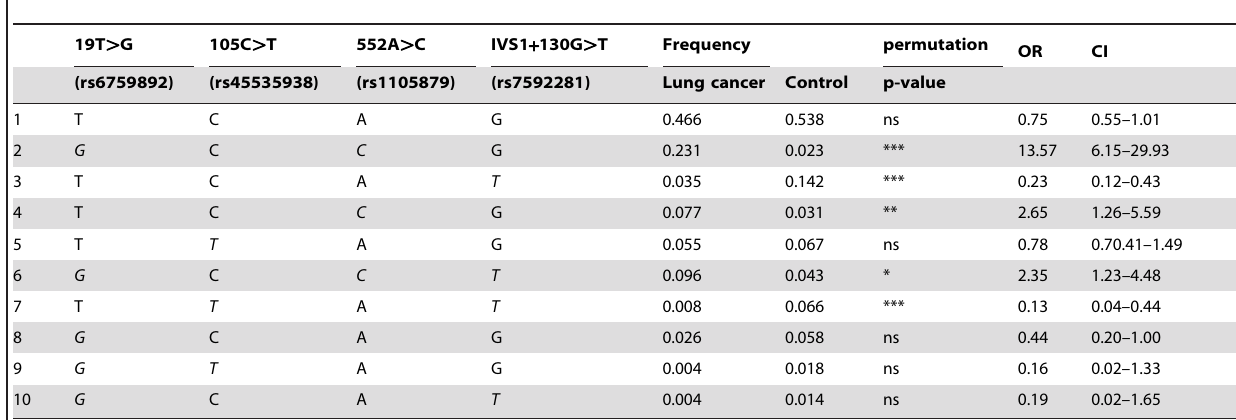
Table 5. Haplotype frequency estimates and significant levels of case-control comparison from permutation tests.